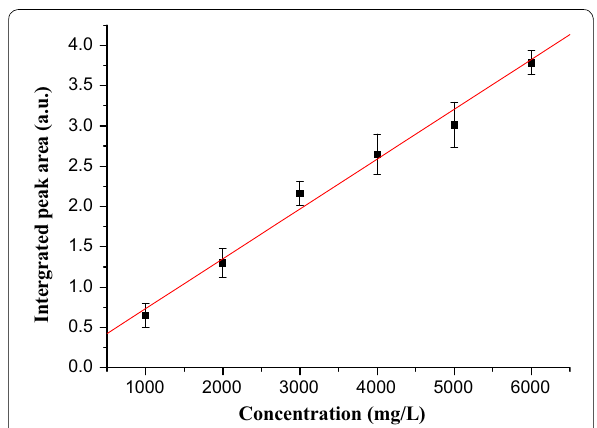
Fig. 2 Graph of concentration versus integrated peak area for stand‑ ard caffeine in